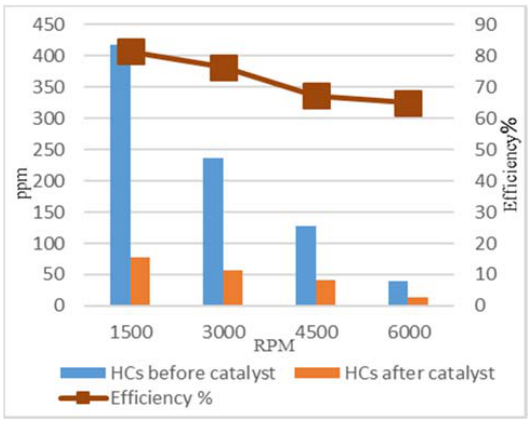
Figure 13. HC conversions with 8 wt.% ZrO 2 ‐ Co 3 O 4 /TiO 2 .